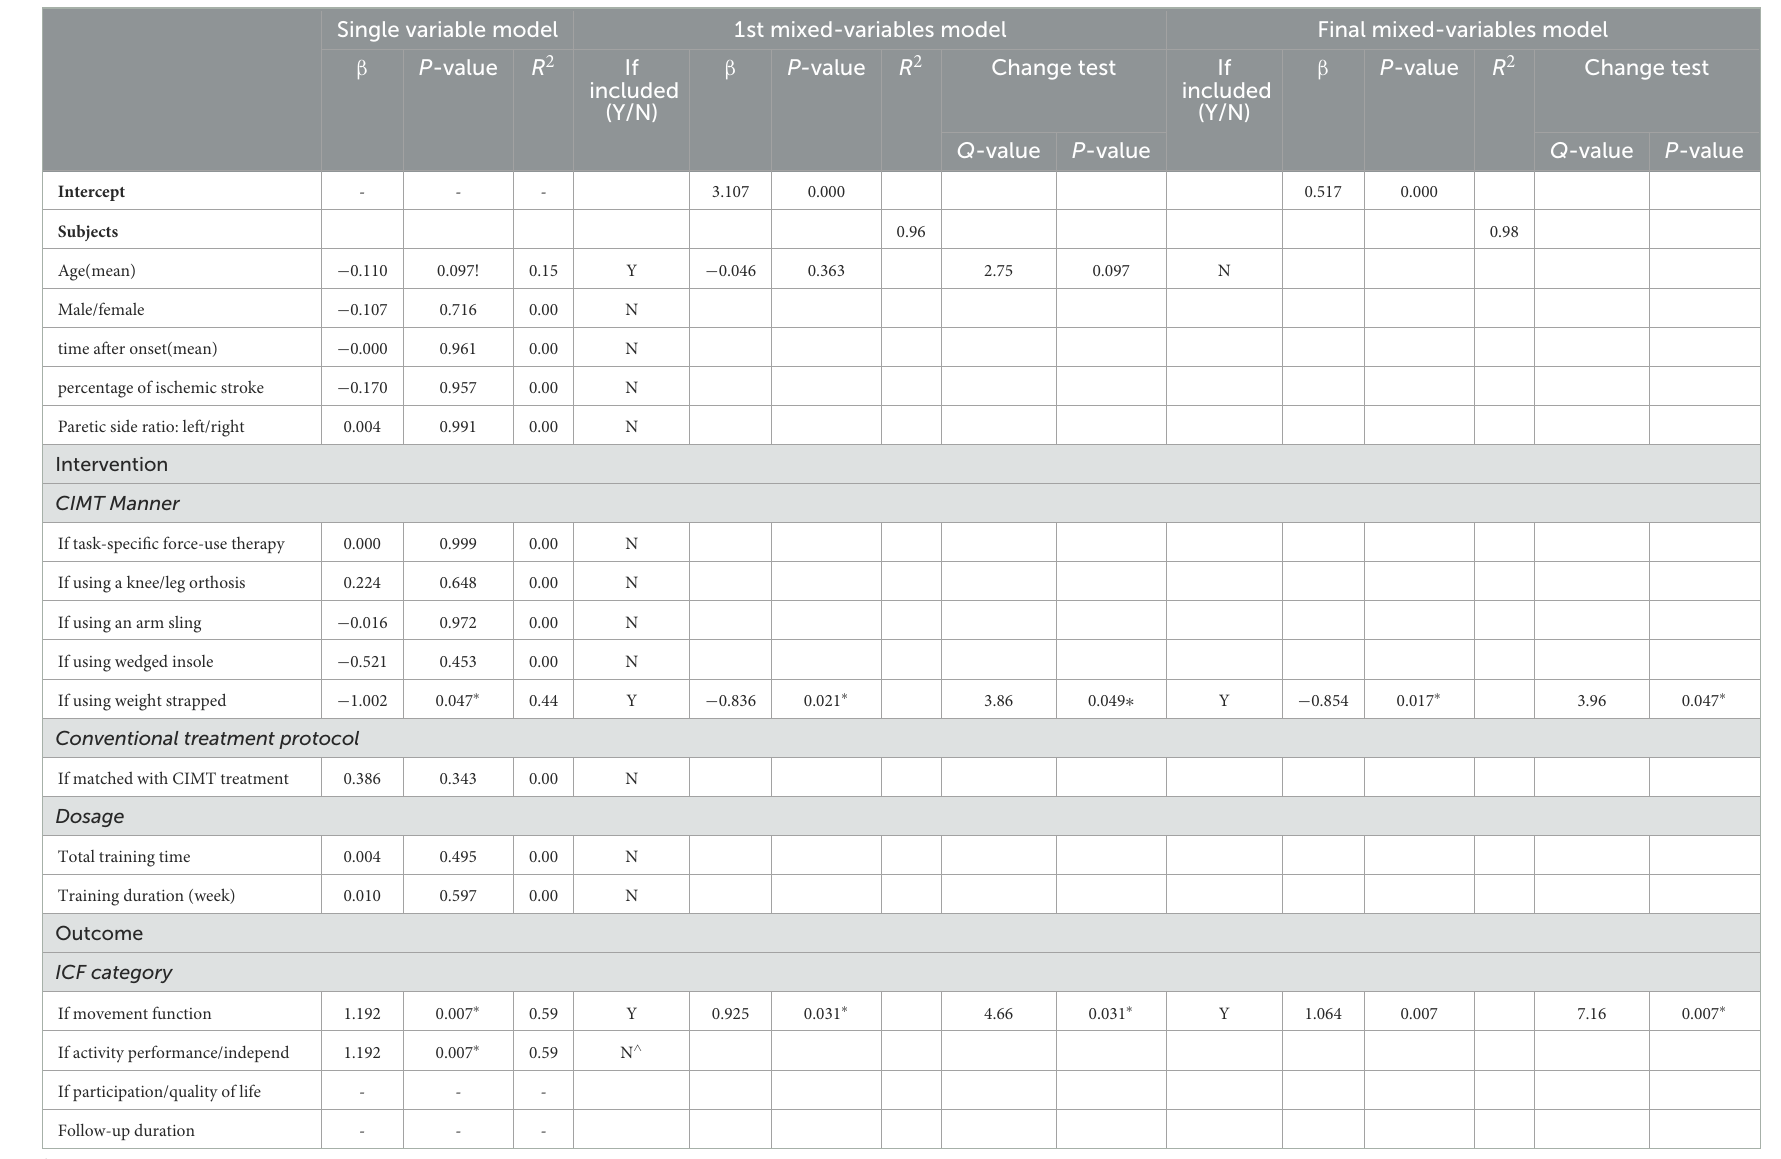
TABLE 3 Contributing factors to the heterogeneity of short-term effect sizes on the overall outcome of CIMT compared to conventional treatment using three-step